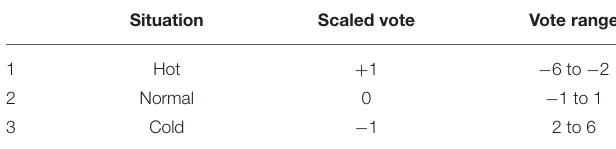
TABLE 2 | Three group definition vote.